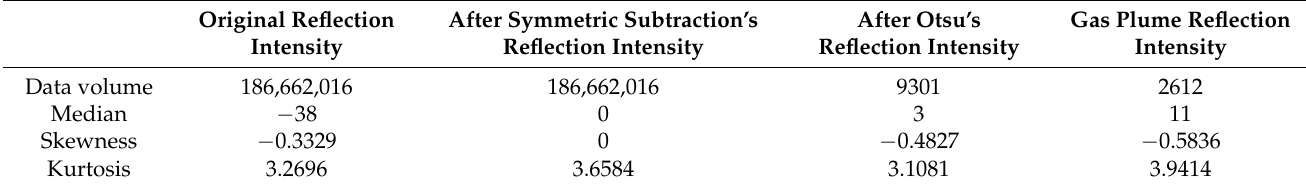
Table 3. Distribution patterns of the backscattered intensity in MWC at different stages of the algorithm. Original